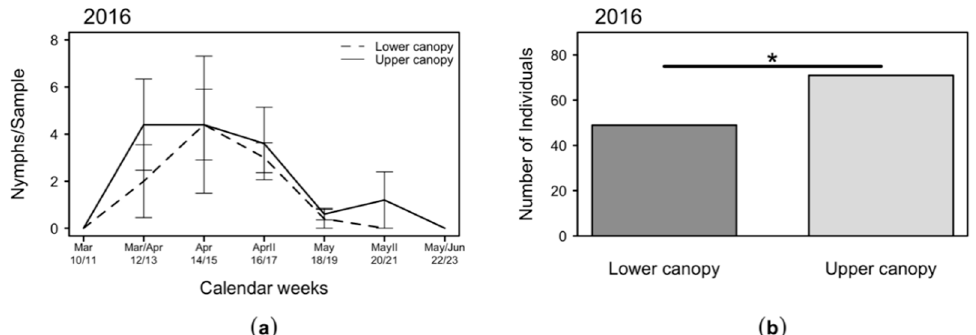
Figure 4. Numbers of C. melanoneura remigrant and emigrant specimens collected at the lower (1 m) and upper (2.5 m) canopy: ( a ) mean + SEM number of specimens collected in a bi-weekly routine per beating tray; ( b ) total catches per year. Significant differences between groups are indicated with * ( p < 0.05) and *** ( p < 0.001).